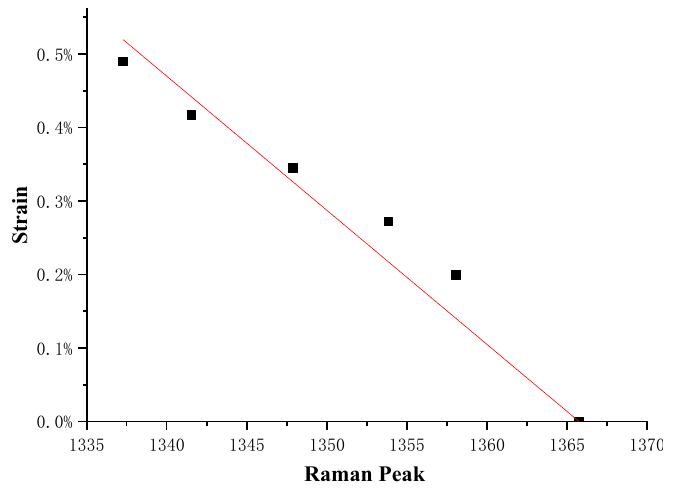
Figure 11. The Raman peak frequency shift caused by the strain in the h-BN flake.